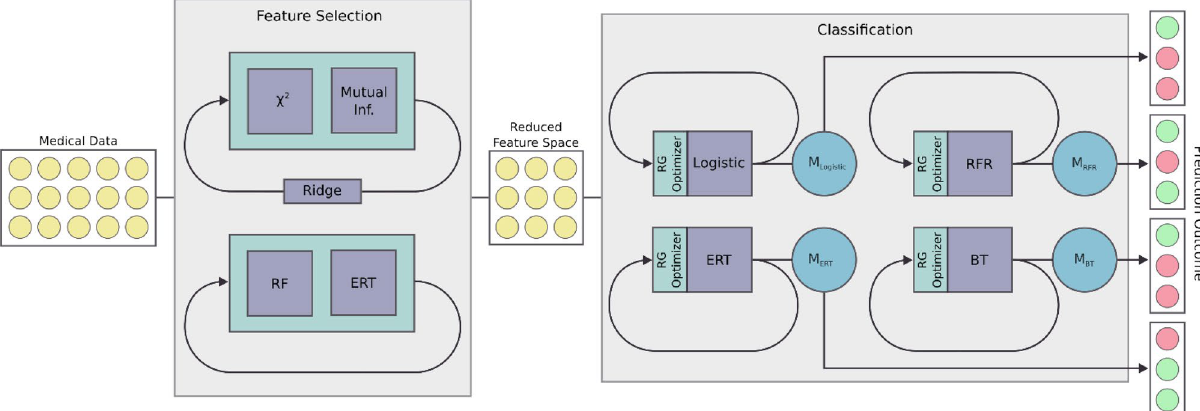
Figure 3. The proposed ML workflow for outcome prediction. The medical data are reduced in terms of features by a Feature Selection scheme (left grey box), then the predicted outcome is obtained by using ML models in a Classification procedure (right grey box). For abbreviations, see “ML models”